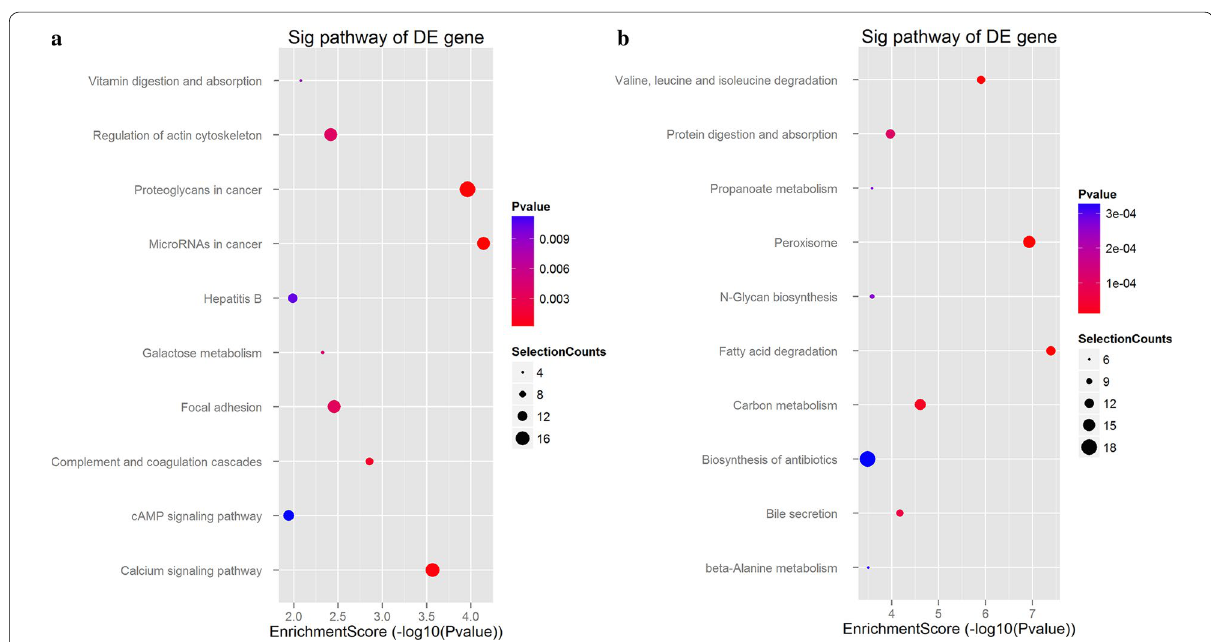
Fig. 3 KEGG pathway analysis of the DEGs in syphilis combined with diabetes. a For target genes of up-regulated gene. b For target genes of down-regulated